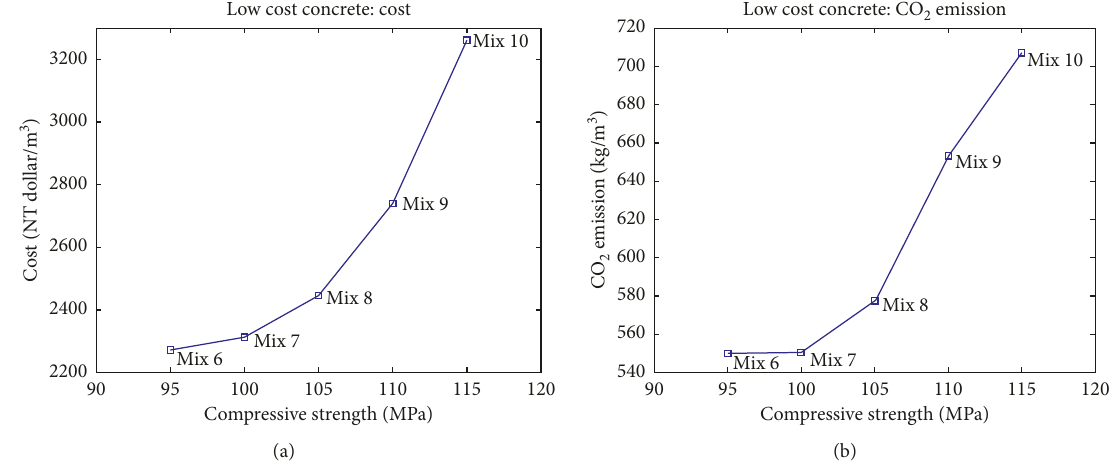
Figure 2: (a) Cost of low-cost concrete. (b) CO Table 9: Mixtures of 110MPa concrete with lower CO